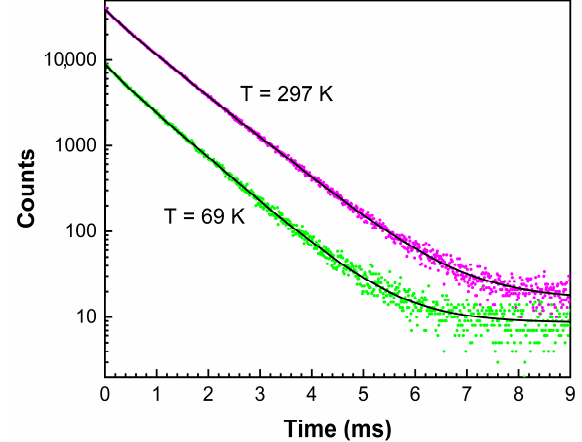
Figure 9. Decay curve of the emission at 17,331 cm −1 under excitation at 28,382 cm −1 at 69 and 297 K. Solid black curves present the results of curve fitting with two decay components listed in the text.